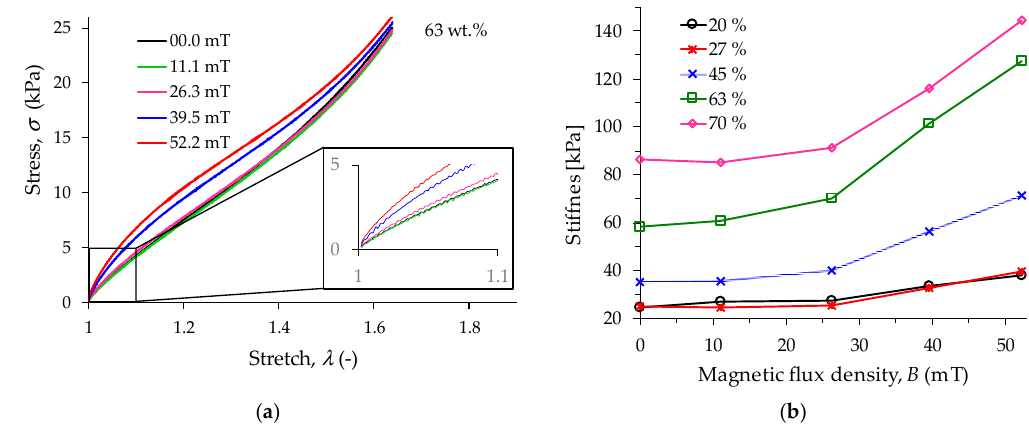
Figure 13. ( a ) Experimental tensile test curves for the composite material with 63 wt % of CIPs were obtained when subjecting the material samples to different magnetic flux intensity values. ( b ) MREs stiffness values obtained from the tensile test with variable magnetic flux density from 0 to 52.2 mT.